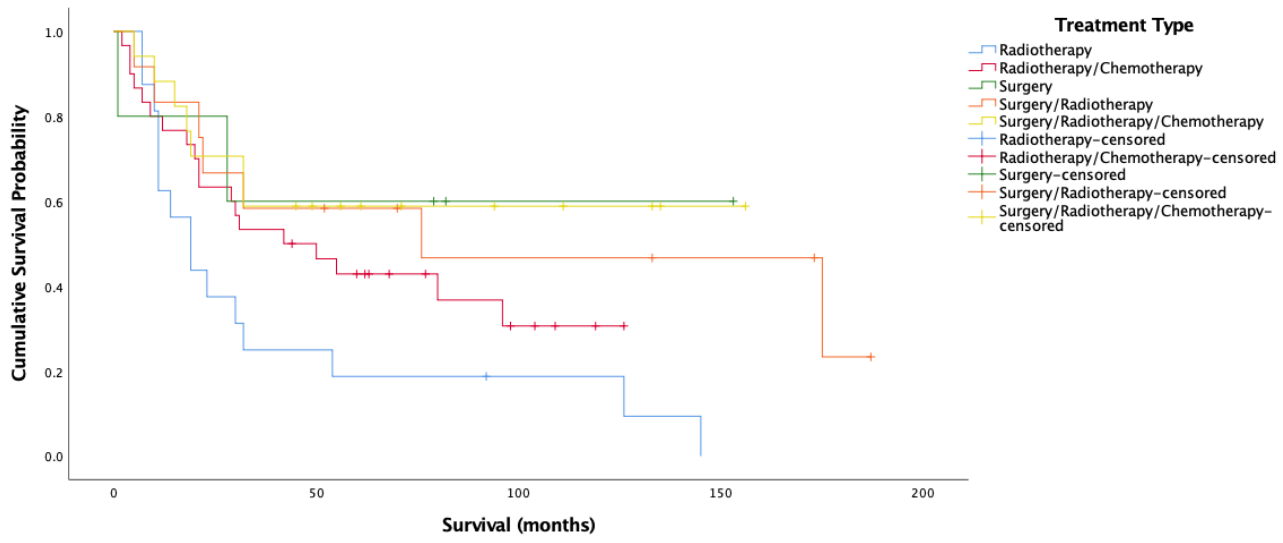
Figure 5. Kaplan – Meier analysis for overall survival amongst HPV-positive oropharyngeal cancer stratified by treatment type (n = 80).